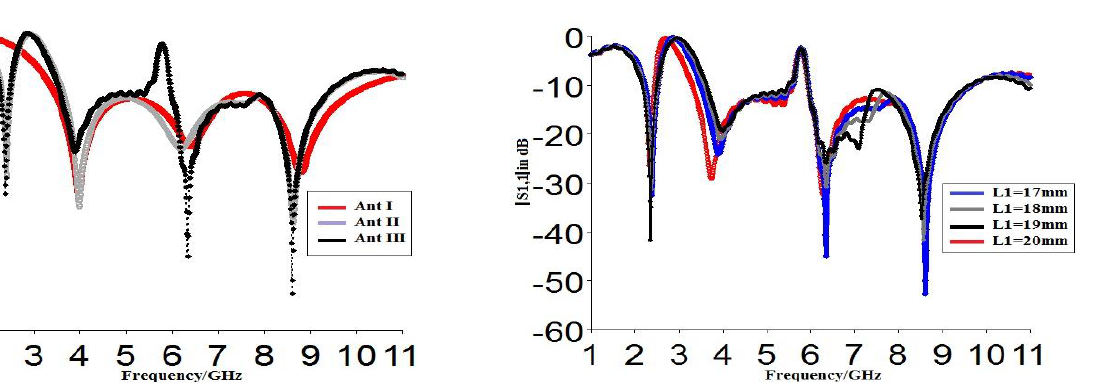
Figure 4: Simulated reflection coefficient for different L 1